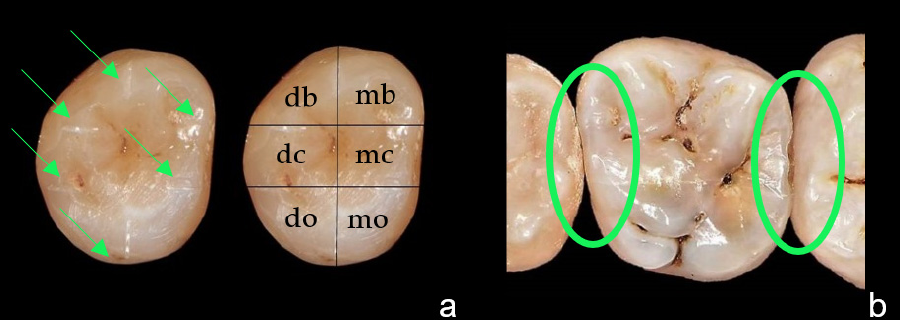
Figure 2. ( a ) Example of a tooth with prepared grooves (green arrows, left) and superimposed with a grid resulting in six areas: mesiobuccal (mb), distobuccal (db), mesiocentral (mc), distocentral (dc), mesio-oral (mo), disto-oral (do, right). ( b ) Example of a tooth with mesio-proximal and disto-proximal areas (green circles).